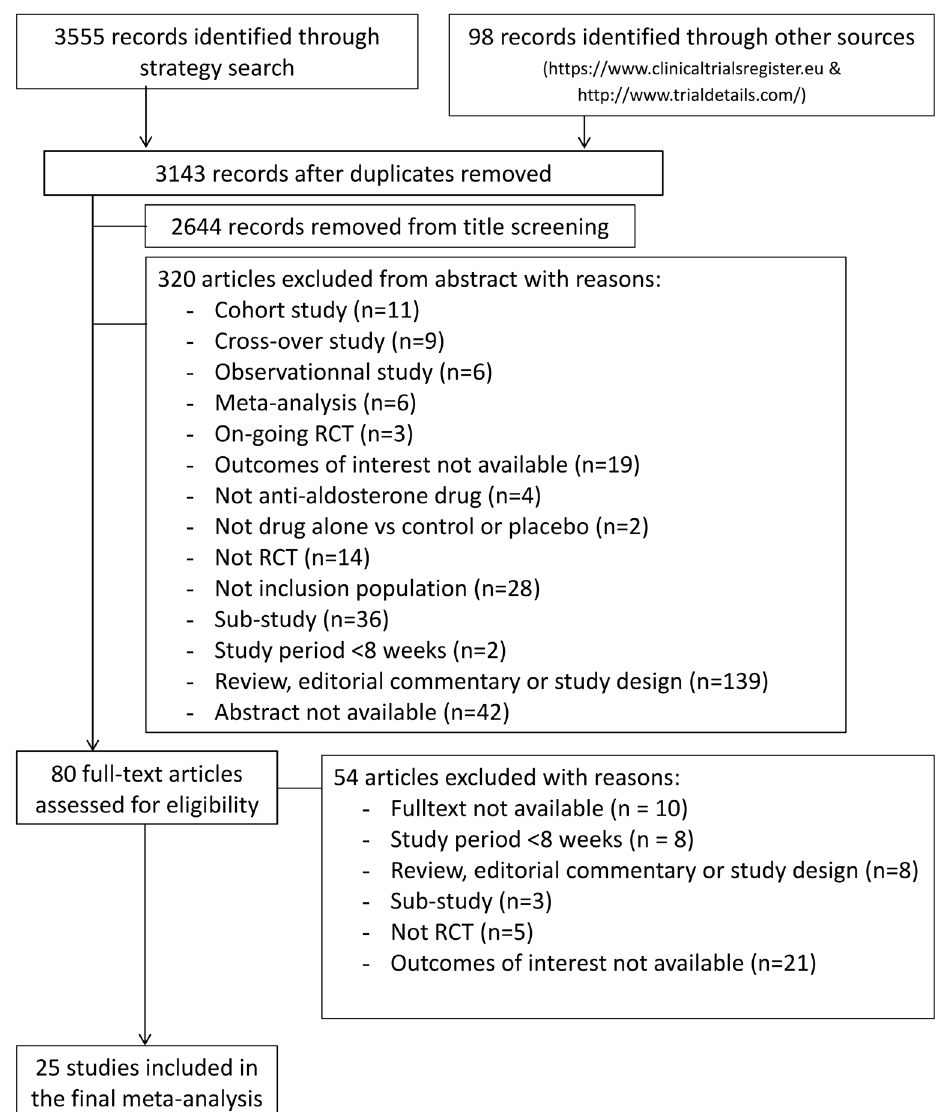
Fig 1. Study flowchart for the selection process of the final included